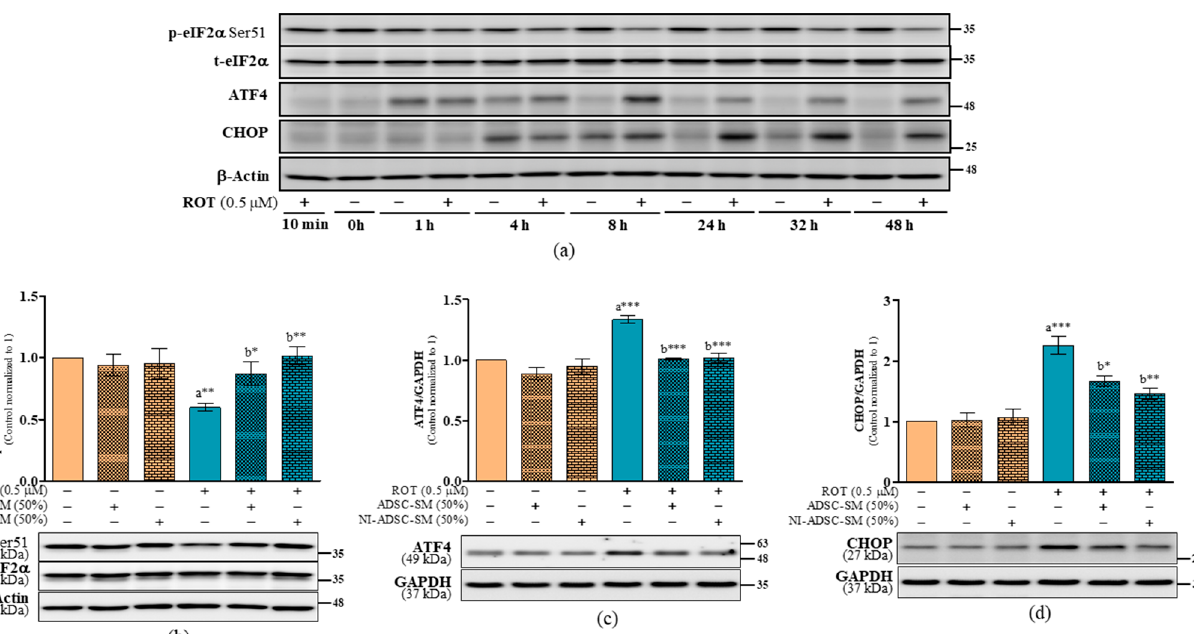
Figure 9. Effects of the NI-ADSC-SM on IRE1 α and SAPK/JNK expression. Cells treated with or without ROT (0.5 μ M) at different timepoints were assessed for IRE1 α and SAPK by Western blotting ( a ). Cells were incubated in the presence of ROT (0.5 μ M) or DMSO for 48 h alone or with the ADSC-SM or NI-ADSC-SM (each diluted by 50%) during the last 24 h. The levels of p-IRE1 α Ser724/t-IRE1 α ( b ) and p-SAPK Thr183-Tyr185/t-SAPK ( c ) protein expression were assessed by Western blotting. Data are shown as the means (bars) and SEM (error bars) of three independent cell culture experiments. Statistical analysis was performed using one-way ANOVA with Tukey’s post-test. Statistical comparisons: a—compared with control; b—compared with ROT; * p < 0.05, ** p < 0.01, and *** p < 0.001. p-, phosphorylated; t-, total.